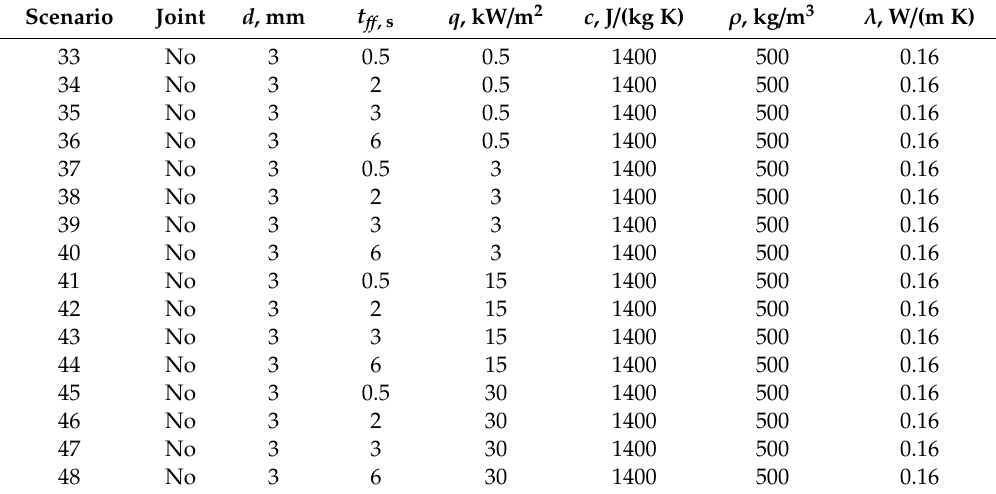
Table A3. The Main Scenarios of Forest Fire Impact on a Stem without a Joint. Part 3.